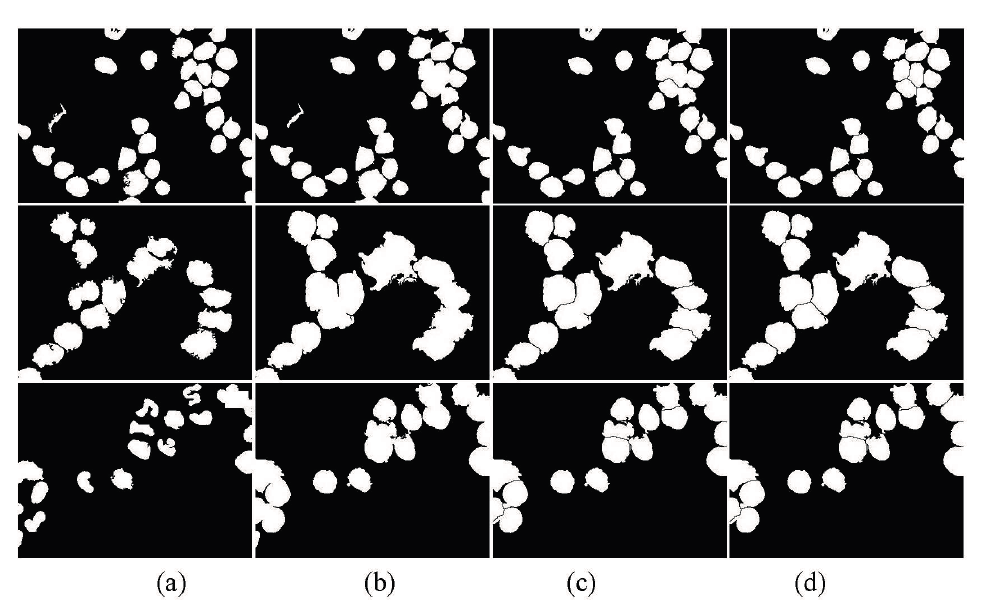
Figure 14. ( a ) Inside seeds; ( b ) Outside seeds; ( c ) First watershed transformation